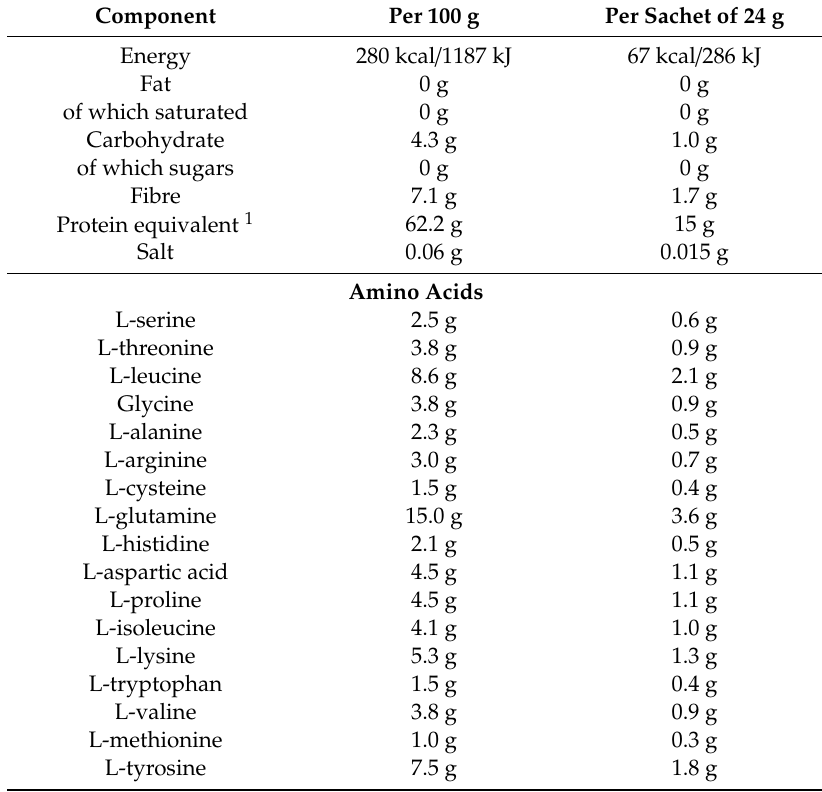
Table 1. Nutritional declaration for the study product (PKU GOLIKE PLUS 3–16) 1